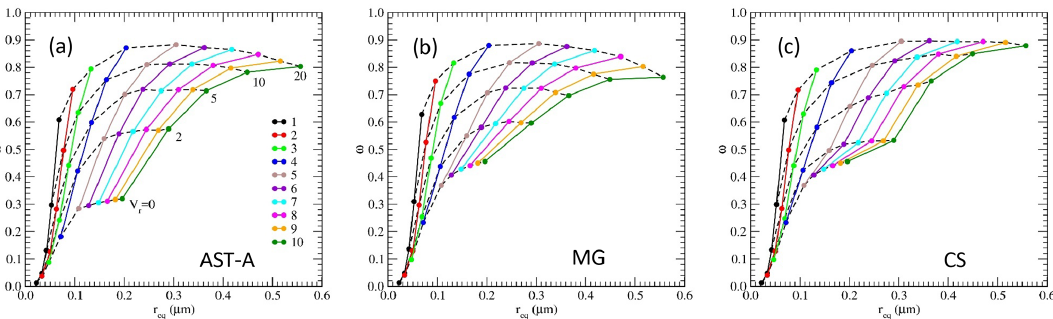
Figure 6. Single-scattering albedo ω versus particle size (volume-equivalent sphere radius: r eq ) at a wavelength of λ = 532nm for the (a) AST model of Type A aggregates (AST-A), (b) Maxwell-Garnett approximation (MG) and (c) core-shell approximation (CS). Results for the same bare soot aggregate at different volume ratios of V r ∼ 0251020 are plotted in the same color. Aggregate numbers are the same as those in Fig. 1.